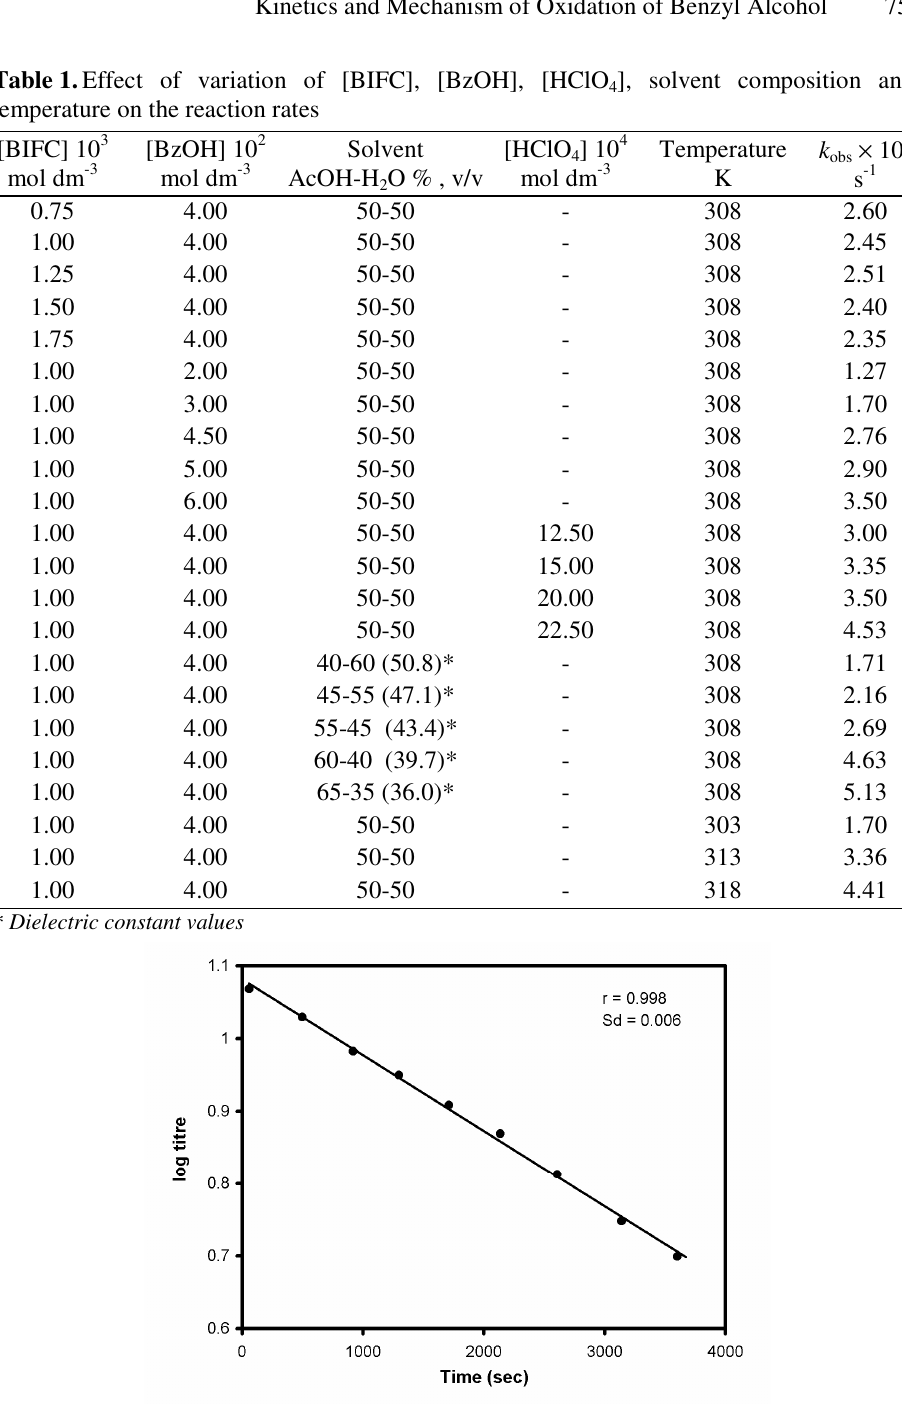
], solvent composition and 4